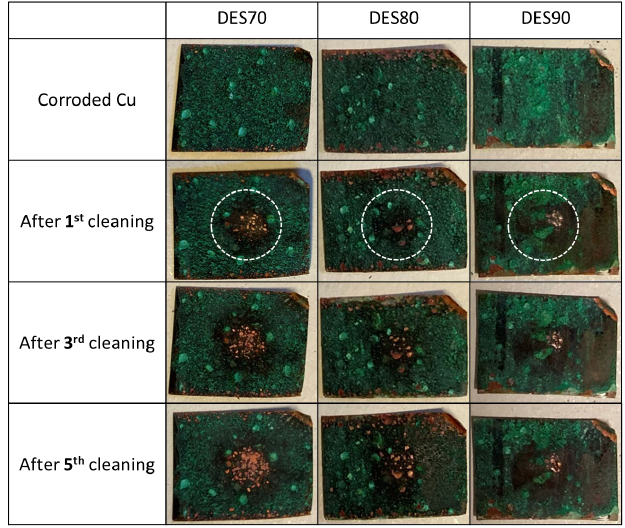
Figure 2. Photos of corroded copper sheets before cleaning, as well as after 1st, 3rd, and 5th cycle of cleaning. Circles with broken white lines designate the area cleaned with cotton swabs containing DES aq.